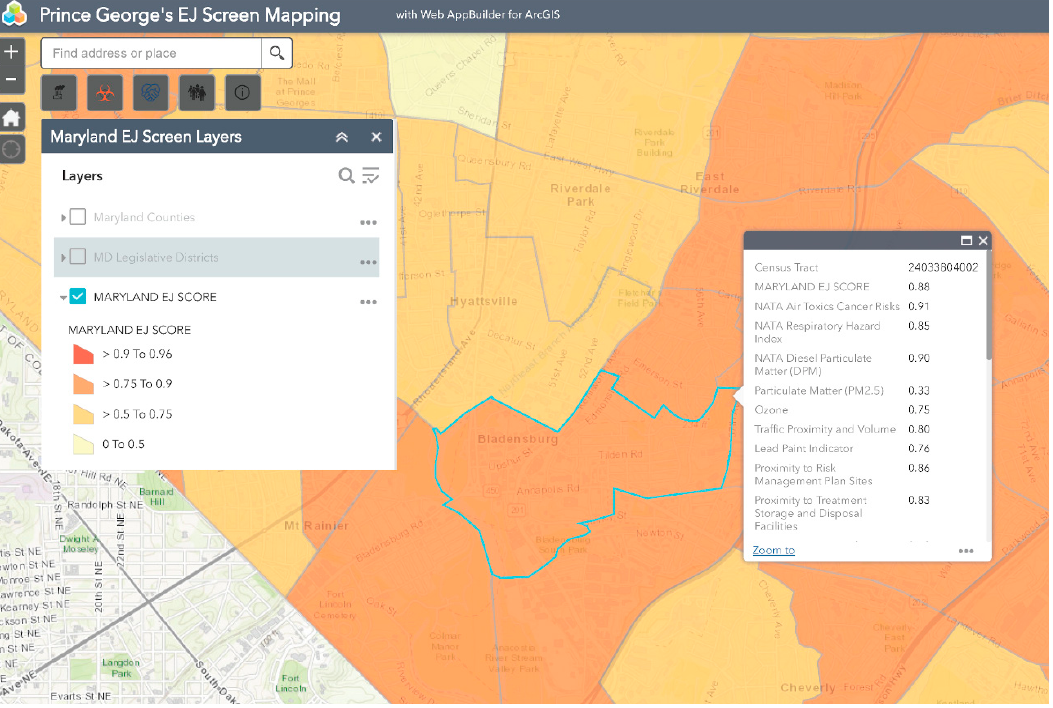
Figure 2. MD EJ Score for Bladensburg. This screenshot from the MD EJSCREEN mapping tool shows the MD EJ Score layer for Bladensburg, MD.